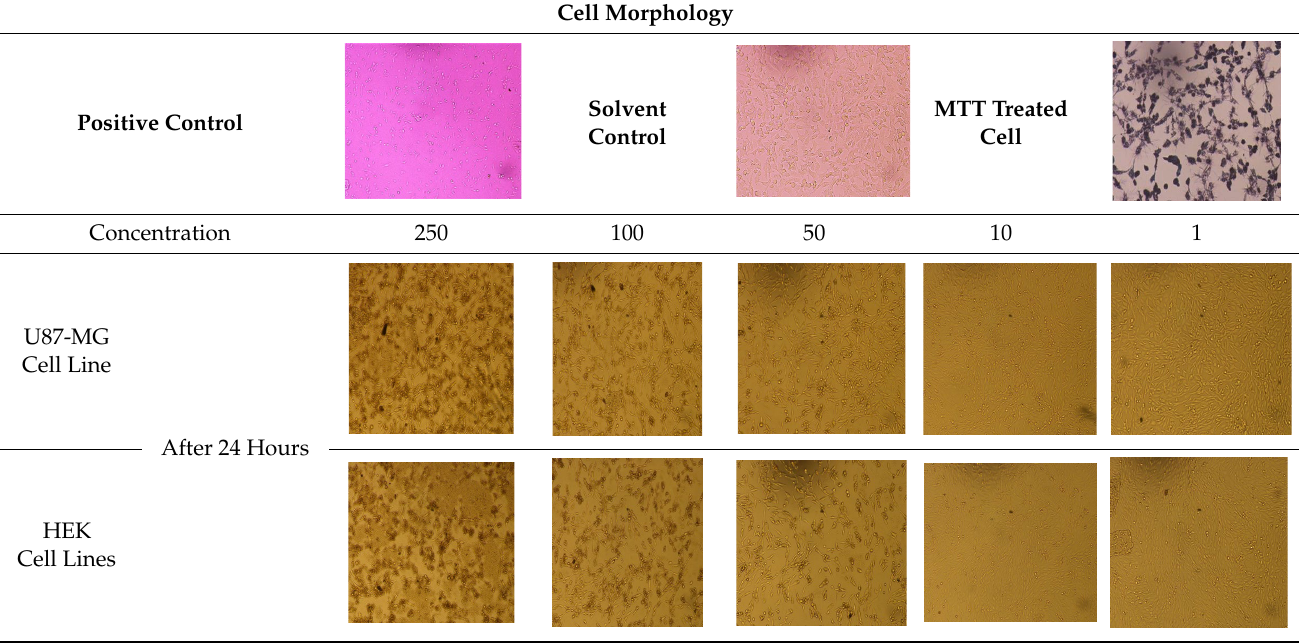
Table 7. Morphology of U87-MG and HEK cell lines after 24 h and comparison with the control. Table 7. Morphology of U87 - MG and HEK cell lines after 24 h and comparison with the control. Table 7. Morphology of U87 - MG and HEK cell lines after 24 h and comparison with the control. Table 7. Morphology of U87 - MG and HEK cell lines after 24 h and comparison with the control. Table 7. Morphology of U87 - MG and HEK cell lines after 24 h and comparison with the control. Table 7. Morphology of U87 - MG and HEK cell lines after 24 h and comparison with the control. Table 7. Morphology of U87 - MG and HEK cell lines after 24 h and comparison with the control. Table 7. Morphology of U87 - MG and HEK cell lines after 24 h and comparison with the control. Table 7. Morphology of U87 - MG and HEK cell lines after 24 h and comparison with the control. Table 7. Morphology of U87 - MG and HEK cell lines after 24 h and comparison with the control. Table 7. Morphology of U87 - MG and HEK cell lines after 24 h and comparison with the control. Table 7. Morphology of U87 - MG and HEK cell lines after 24 h and comparison with the control. Cell Morphology Cell Morphology Table 7. Morphology of U87 - MG and HEK cell lines after 24 h and comparison with the control. Table 7. Morphology of U87 - MG and HEK cell lines after 24 h and comparison with the control. Cell Morphology Cell Morphology Cell Morphology Cell Morphology Cell Morphology Cell Morphology Cell Morphology Cell Morphology